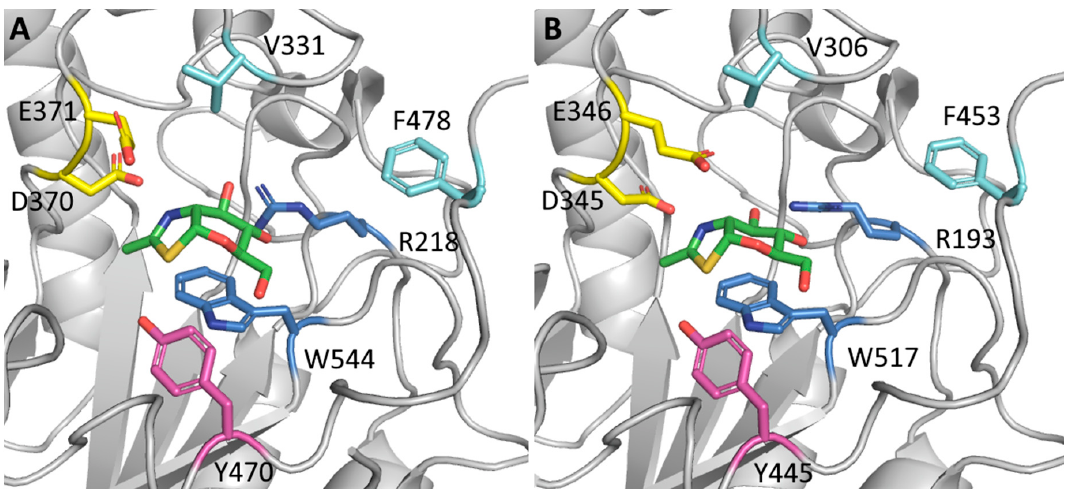
Figure 5. Active sites of two fungal β - N -acetylhexosaminidases: ( A ) homology model of Tf Hex from Talaromyces flavus with the inhibitor Glc-thiazoline docked (created with YASARA [138]); ( B ) crystal structure of Ao Hex from Aspergillus oryzae (PDB: 5OAR [139]) with the inhibitor Glc-thiazoline bound. The catalytic Asp-Glu pair is highlighted in yellow, the water-stabilizing Tyr residue is highlighted in purple, bound or docked ligands are highlighted in green, conserved residues (Arg and Trp) are highlighted in dark blue, and residues involved in aglycone binding are highlighted in light blue (Phe and Val).